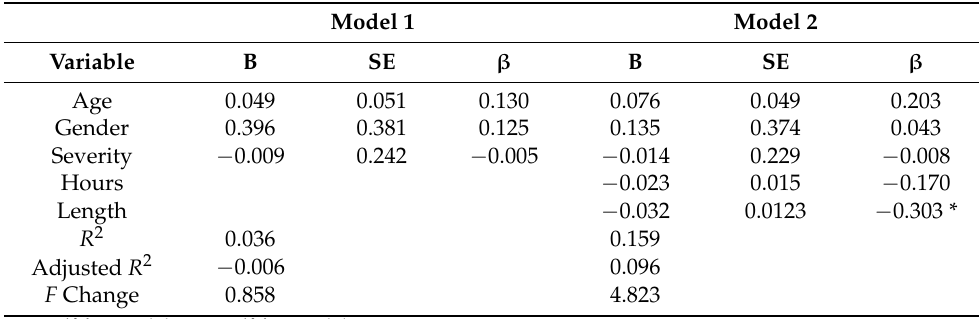
Table 7. Hierarchical Regression Analysis for Prediction of School